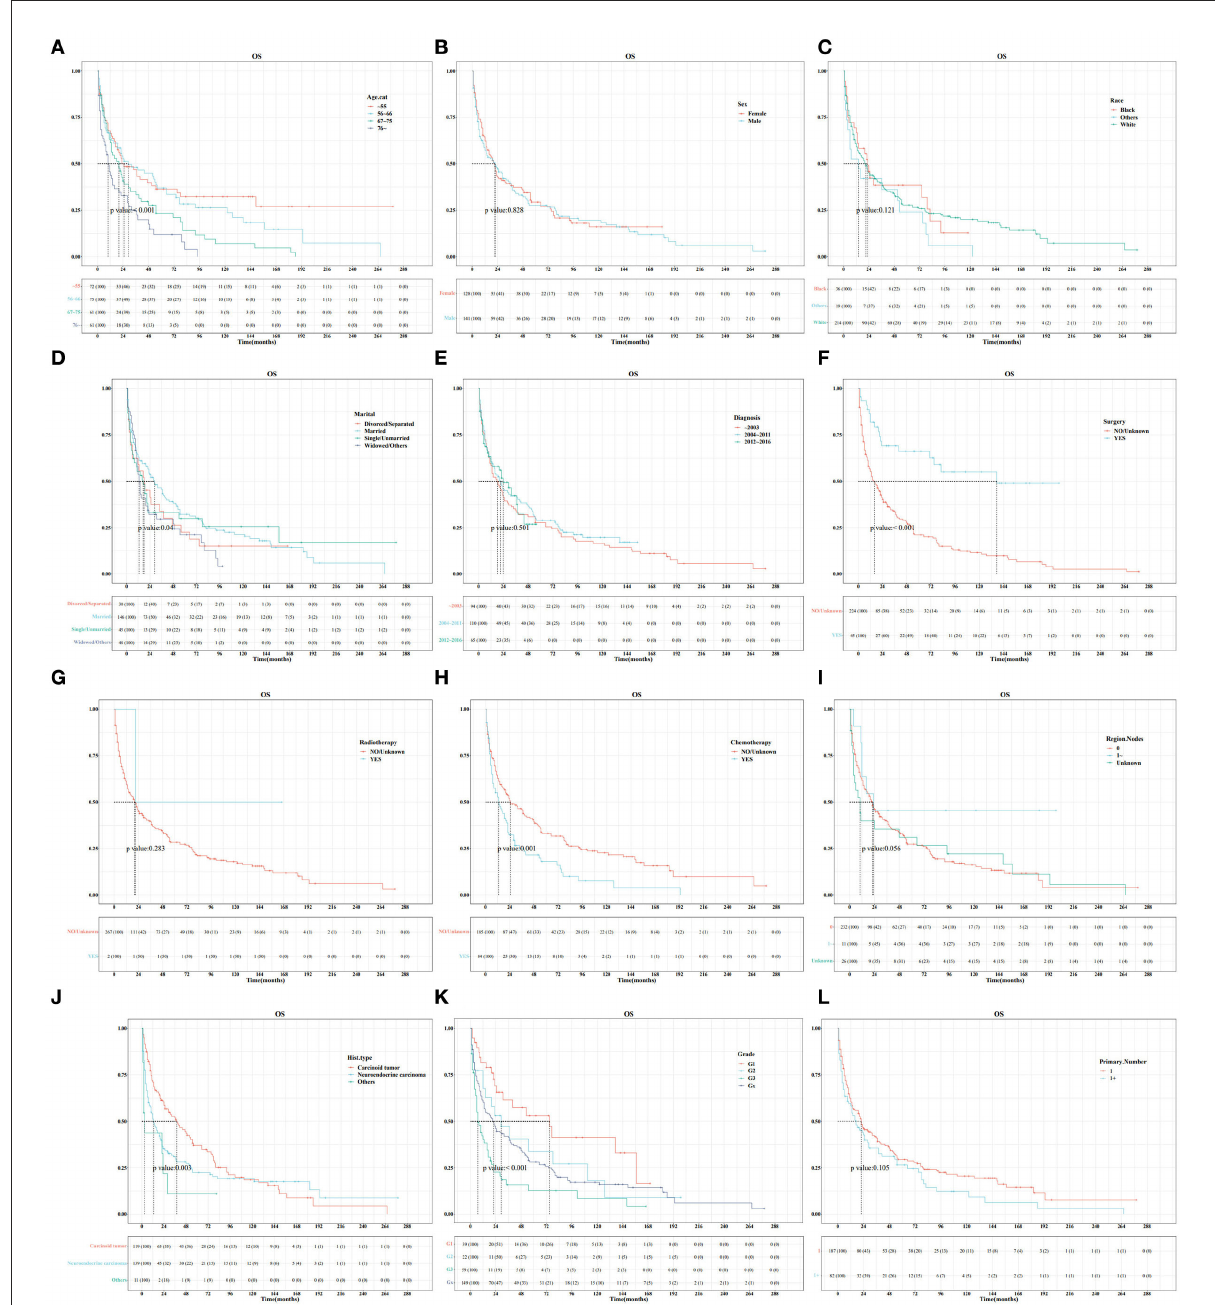
FIGURE1 Survival curve analysis of the influence of the main variables on the overall survival (OS) of patients with primary hepatic neuroendocrine tumor (PHNET) in the training set. (A) age; (B) sex; (C) race; (D) marital status; (E) year of diagnosis; (F) surgery; (G) radiotherapy; (H) chemotherapy; (I) number of regional lymph nodes; (J) histological type; (K) grade; and (L) number of primary malignancies.